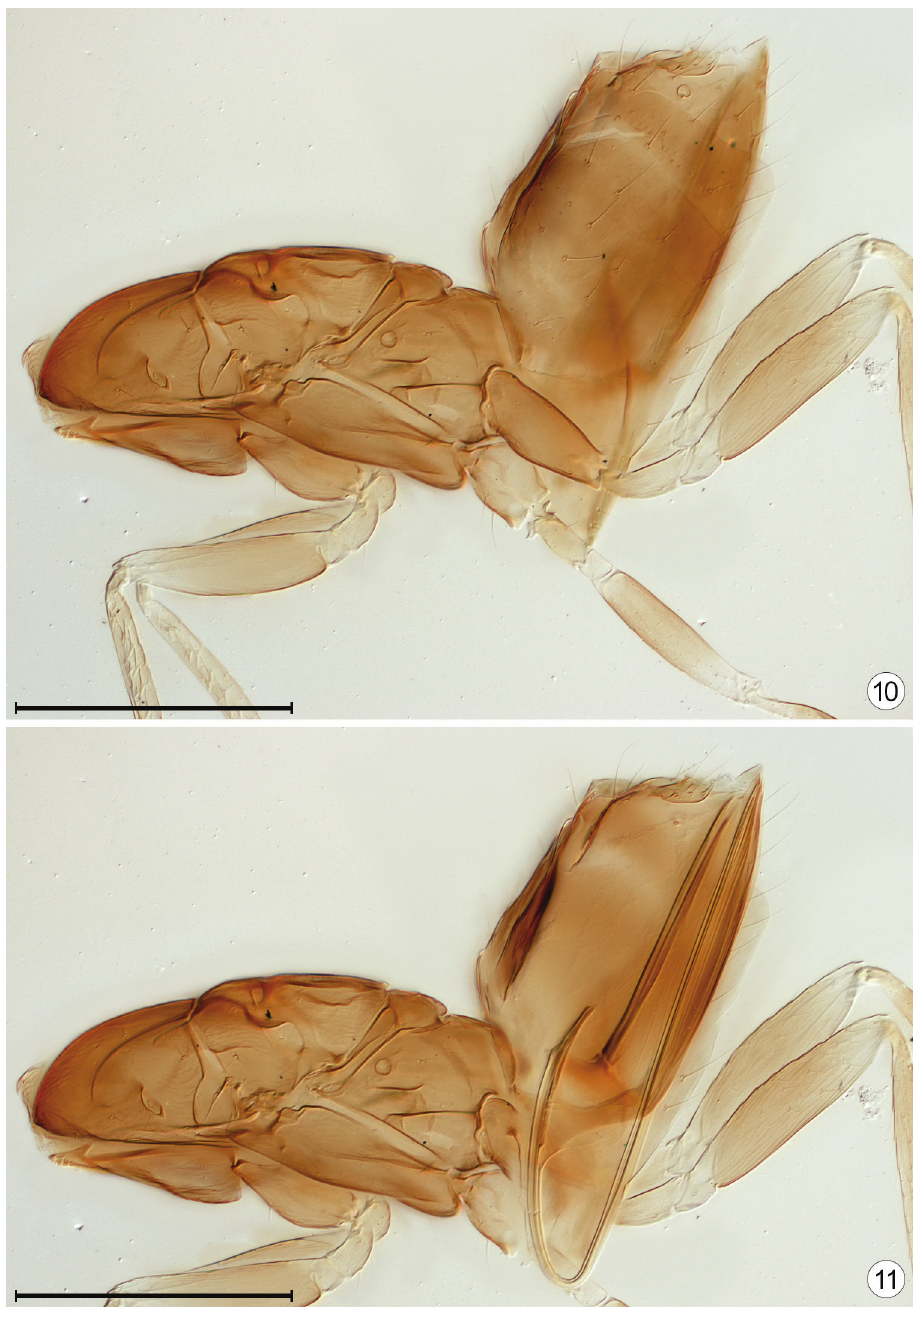
Figures 10, 11. Anaphes brevis , body, lateral. 10 outer surface 11 median view of gaster showing ovipositor. Scale bars: 200